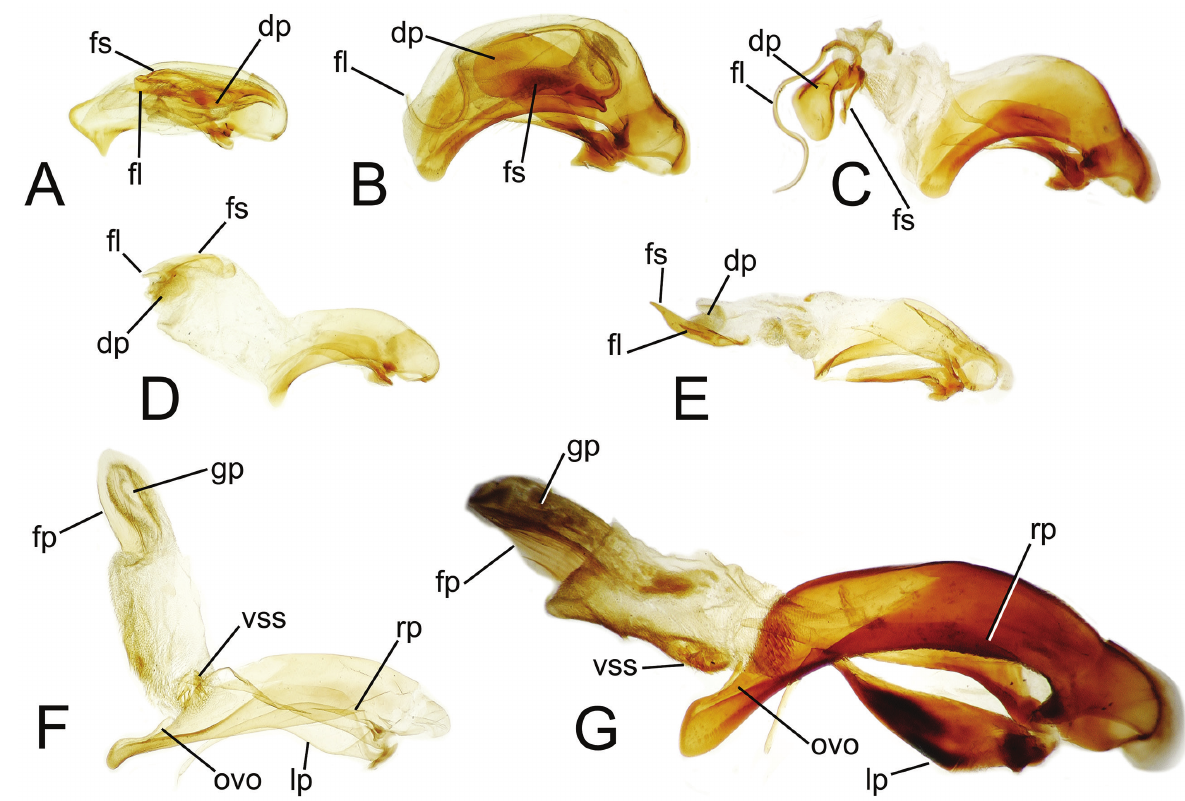
Figure 4. Male aedeagal median lobe and parameres of Mecyclothorax spp., right lateral view, internal sac everted in C–G : A , M. blackburni ; B–C , M. peryphoides ; D , M. moorei ; E , M. lewisensis ; F , M. punctipennis ; G , M. montivagus . See Table 2 for